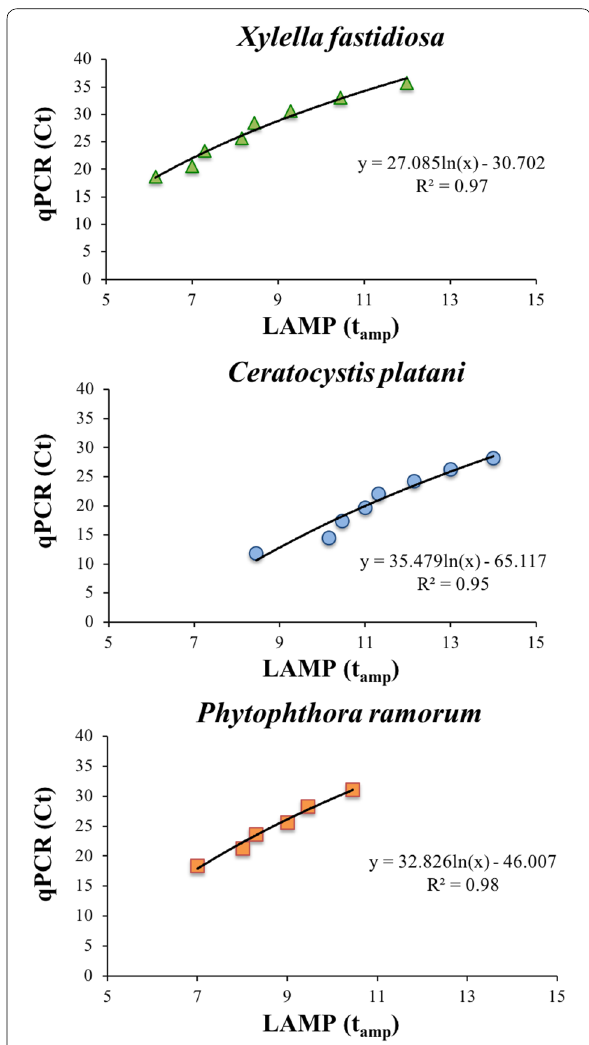
Fig. 3 Statistical correlation between LAMP amplification time (t amp ) and qPCR threshold cycle (C t ) obtained by testing with both methods each 1:5 serial dilution (ranged from 10 ng μL − 1 to 0.128 pg μL − 1 ) of each standard DNA template ( X. fastidiosa —Co.Di.Ro strain; C. platani —isolate Cp24; P. ramorum -isolate